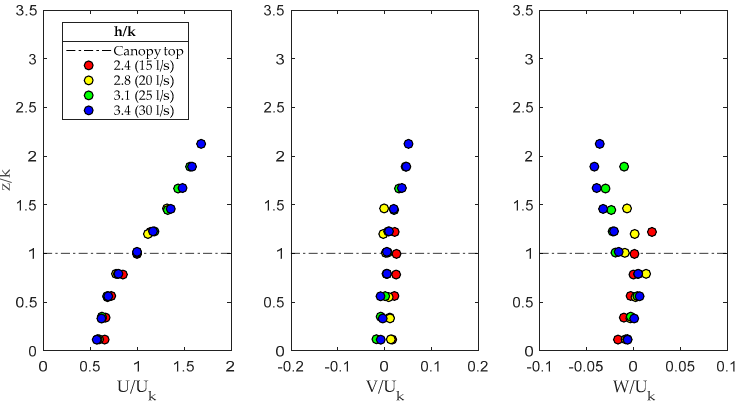
Figure 3. Dimensionless mean velocity profiles for U, V, and W . Dash-dotted line indicates the canopy top.